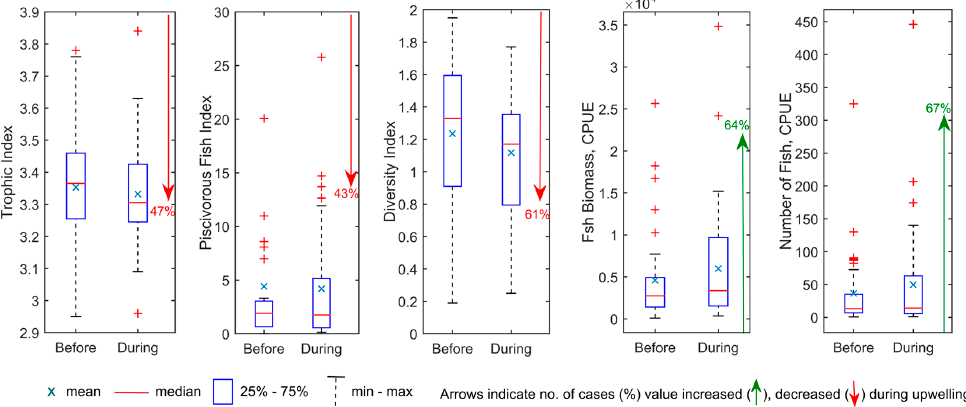
Figure 6. The minimum, maximum, mean, and median values of fish community-based ecological indices, fish biomass, and number of fish before and during an upwelling event. Boxplots indicate 25–75% percentiles.